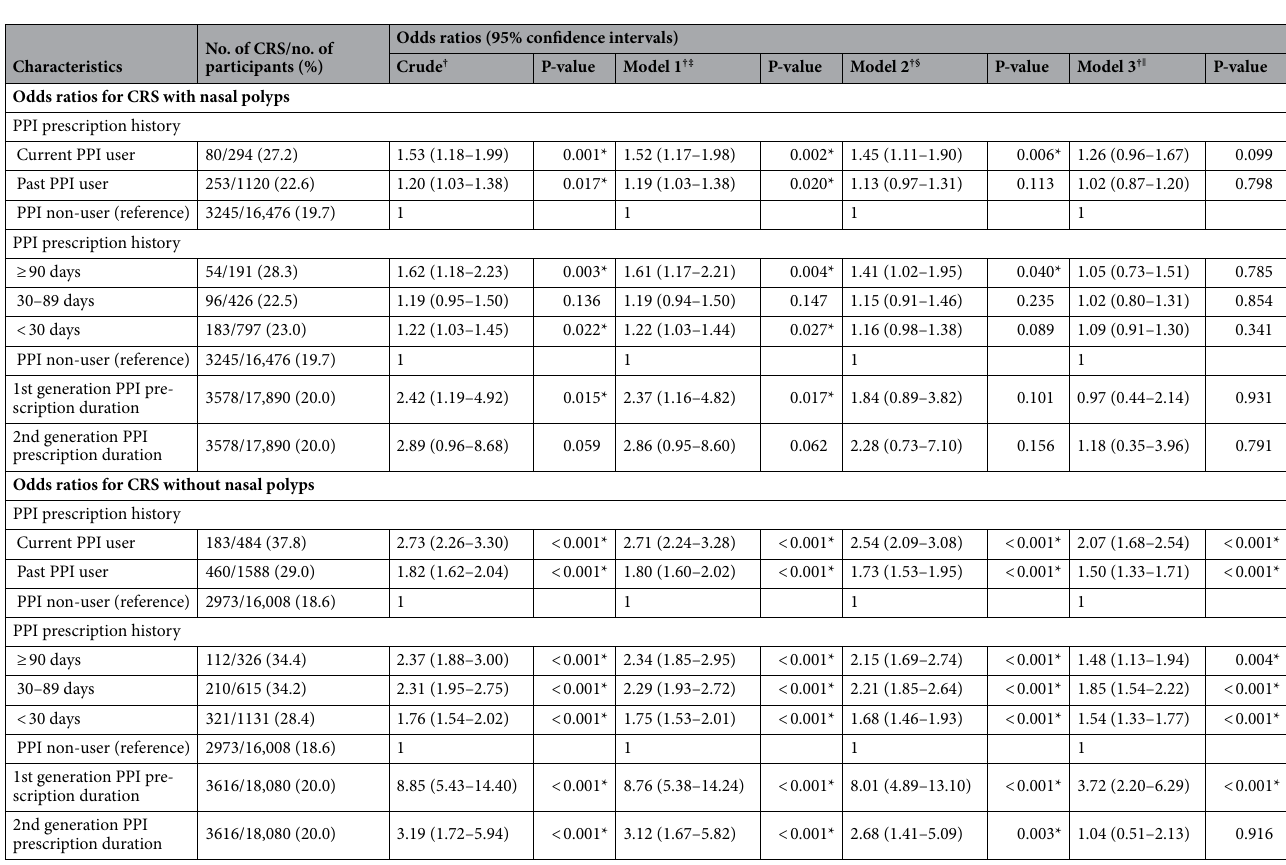
Table 3. Odds ratios (95% confidence intervals) of PPI prescription history/PPI prescription duration/ each generation PPI prescription duration for CRS with nasal polyps and for CRS without nasal polyps.